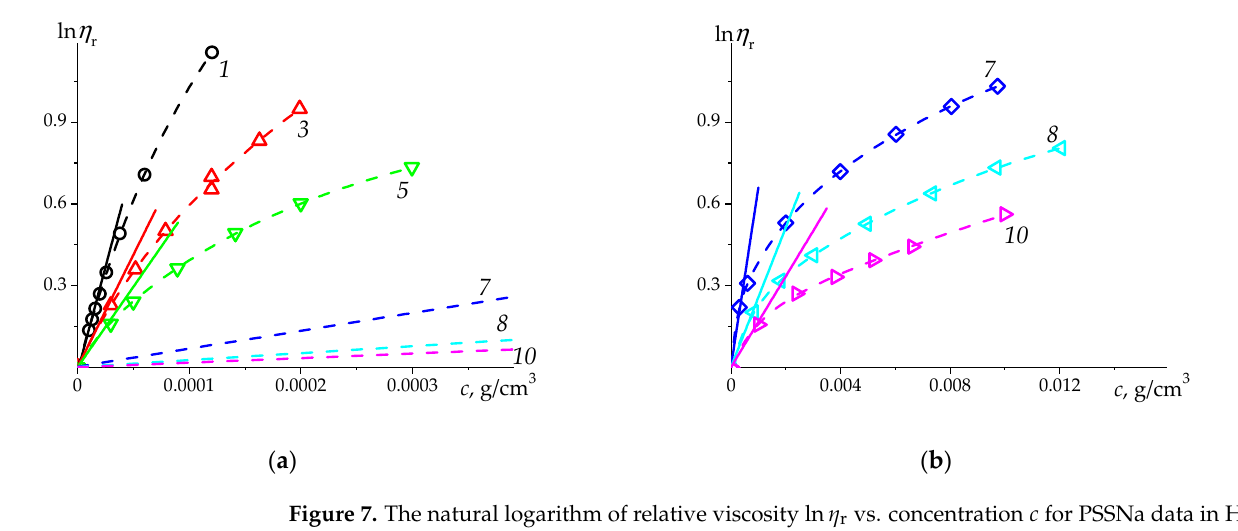
Figure 7. The natural logarithm of relative viscosity ln η r vs. concentration c for PSSNa data in H 2 O at 25 ◦ C. The dashed curves are the 2-nd degree polynomial fit of the presented data sets, the solid lines correspond to the initial slope of the dependences representing the intrinsic viscosity value, as [ η ] = d ( ln η r ) / dc at c = 0. The numbers next to the lines correspond to the sample numbering in the Table 5. The lines 7, 8 and 10 on the ( a ) represent the slopes from the ( b ). Table 5. The molecular masses 𝑀 (cid:2929)(cid:2888) , the values of intrinsic viscosities [𝜂] and parameters 𝐵 (cid:2870) (Eq. 4) for PSSNa in H 2 O at 25 ° С . 𝟏𝟎 (cid:2879)𝟑 , 𝑴 𝐬𝐃 Sample g/mol